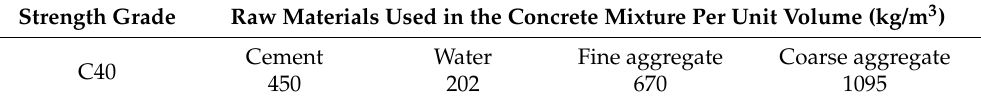
Table 1. Mix proportion of C40 strength grade